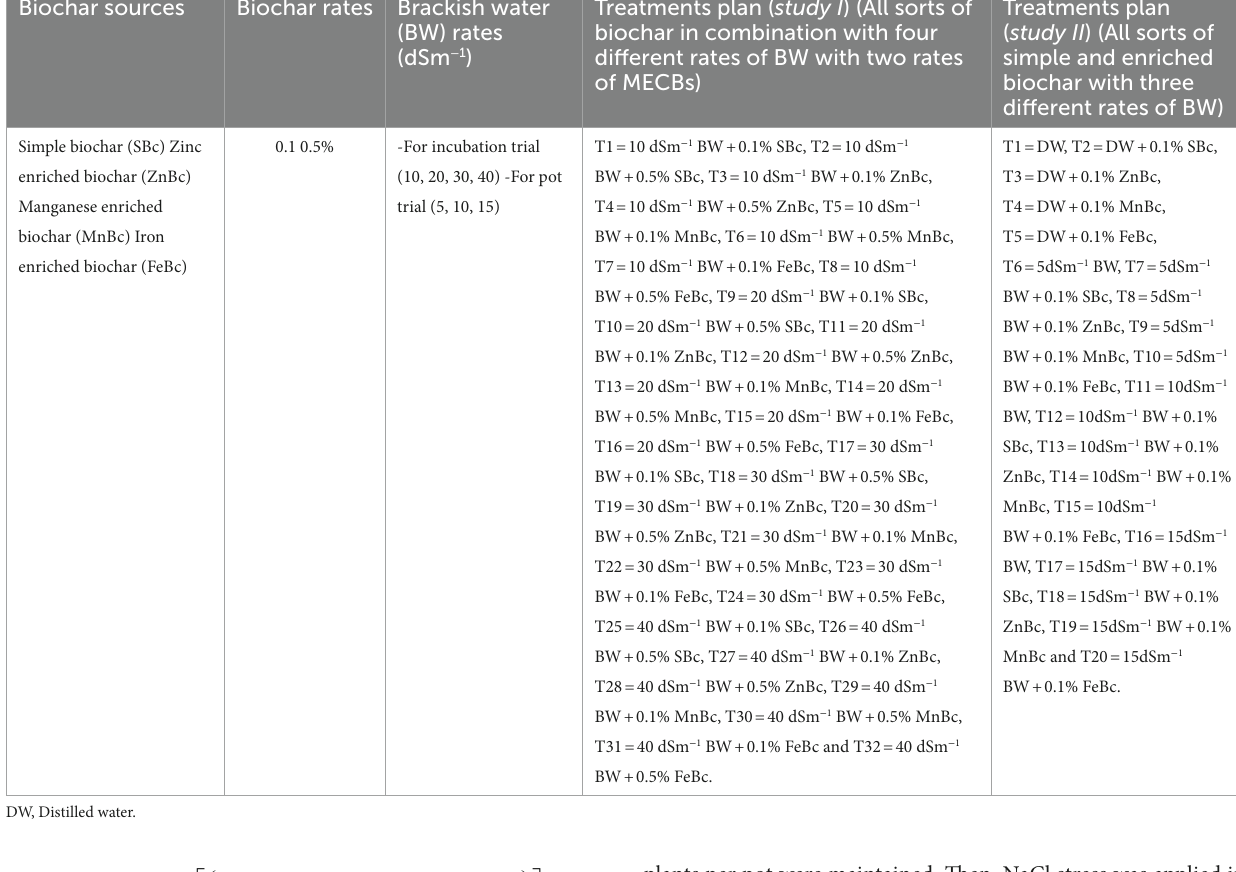
TABLE 1 Experimental design for the proposed studies. Biochar